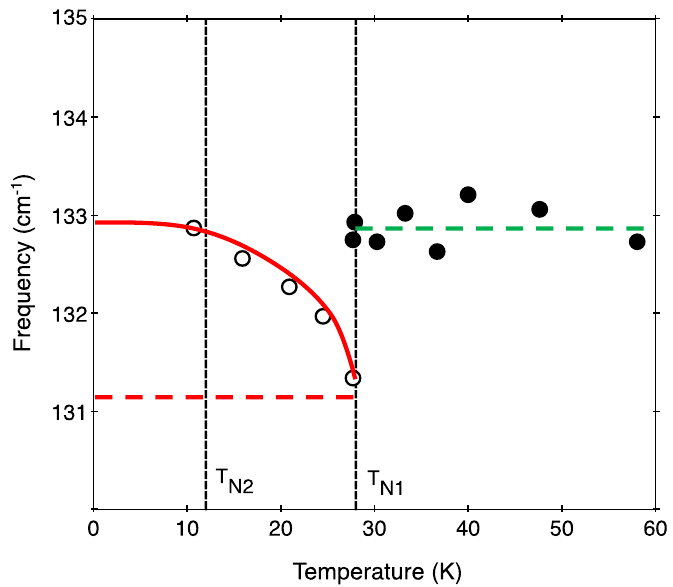
Figure 5. The same as in Fig. 4, but for the E 2g phonon mode frequency.